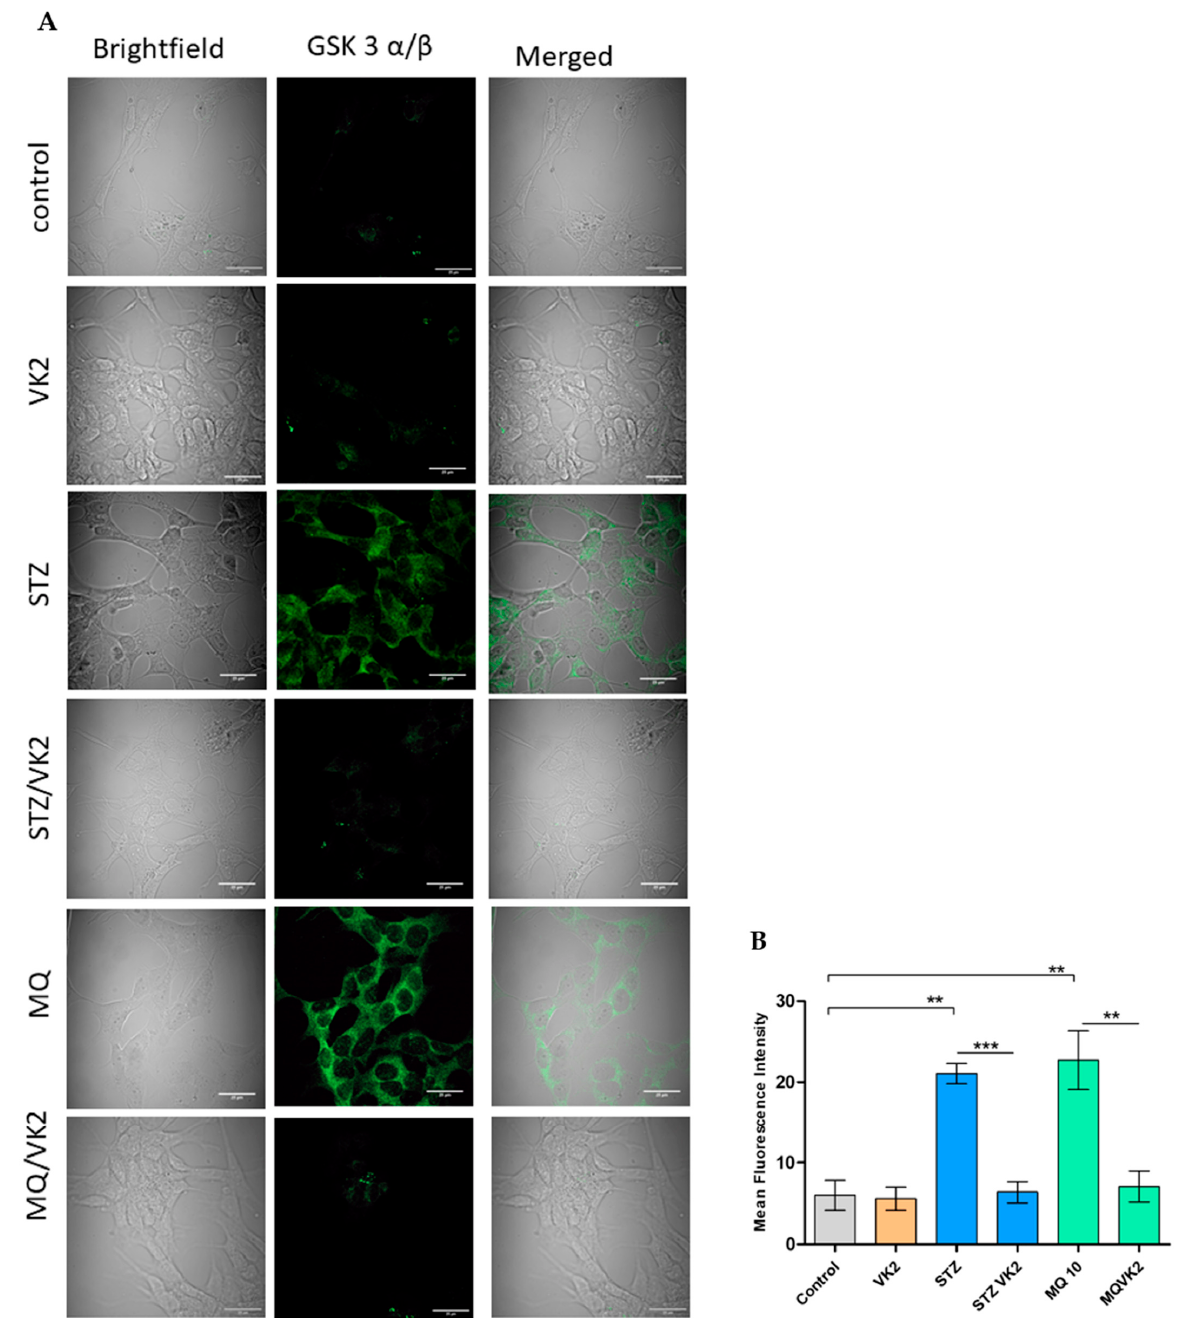
Figure 7. Determination of GSK-3 alpha/beta (p-Tyr216, p-Tyr279) expression by immunofluorescence staining using confocal microscopy. ( A ) Images of human SH-SY5Y neuroblastoma cells were taken after streptozotocin and menadione (MQ) exposure and post-treatment with vitamin K2. All images were taken with a 63 × oil objective. Images were taken in brightfield and FITC modes, where AF 488 (green staining) represents GSK-3 alpha/beta (p-Tyr216, p-Tyr279). Further merged mages were used to observe the differences among control, only VK2, streptozotocin (2.5 mM) and its post-treatment with vitamin K2 (50 µ M); menadione (10 µ M) and its post-treatment with vitamin K2 (50 µ M). ( B ) Representative graphs of the mean fluorescence intensity from three different fields of view using ImageJ software. The data are presented as mean ± SEM. Statistical analysis was performed using Student’s t -test and differences with p -value ≤ 0.05 were designated as significant. ** p < 0.01, and *** p < 0.001 denote significant differences compared to the control and between the treatment groups. [STZ—streptozotocin; VK2—vitamin K2; STZ/VK2—post-treatment of streptozotocin (2.5 mM)-treated cells with vitamin K2 (50 µ M); MQ—menadione; MQ/VK2—post-treatment of menadione (10 µ M)-treated cells with vitamin K2 (50 µ